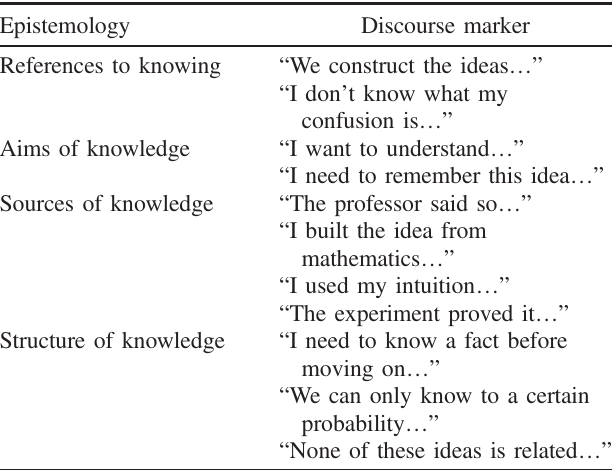
TABLE I. Examples of